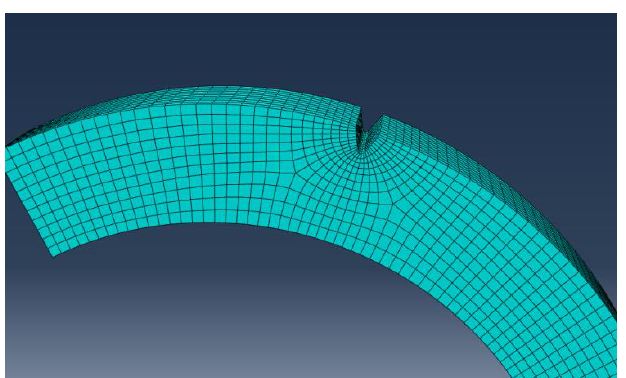
Figure 3. The mesh of 3D arc, C3D10 with 0.5 mm of size.